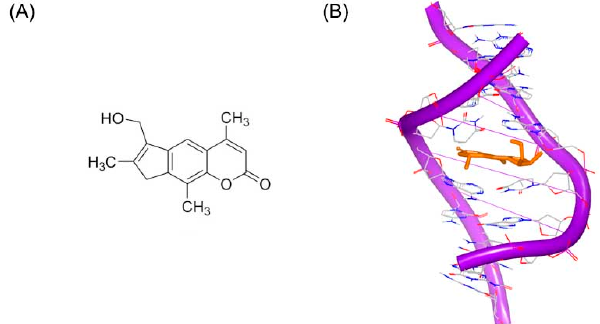
Figure 1. ( A ) Chemical structure of HMT; and ( B ) NMR structure of a short DNA complex with HMT (RCSB Protein Data Bank (PDB) code: 204D). The orange structure represents the small molecule. The purple structure represents the backbone of nucleic acid; the blue and red atoms in the molecule represent nitrogen and oxygen atoms, respectively.